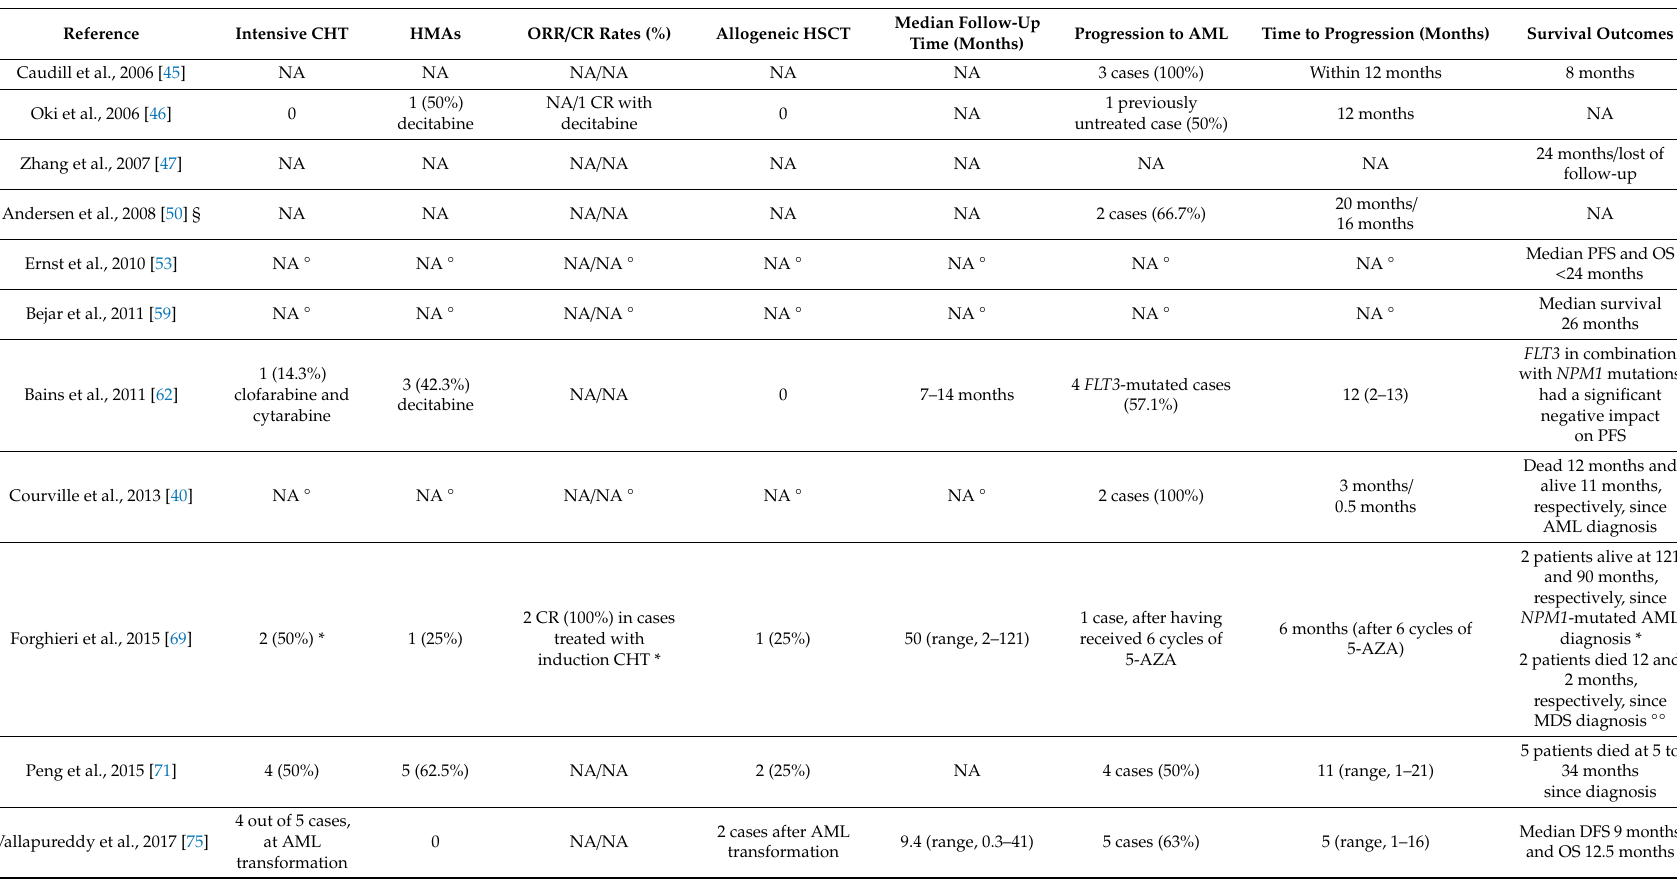
Table 3. Therapeutic approaches and clinical outcomes of NPM1 -mutated MNs with < 20% blasts: review of the